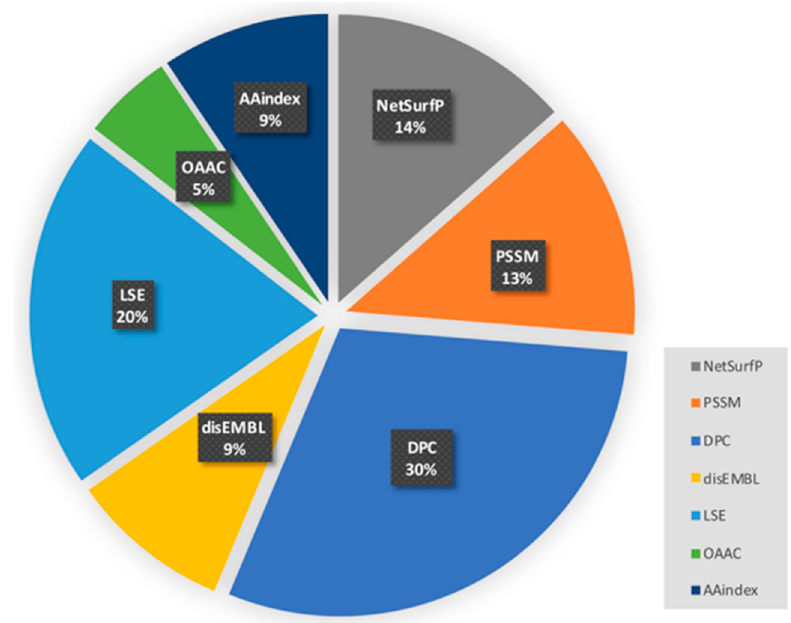
Figure 3. Probability of each feature being selected